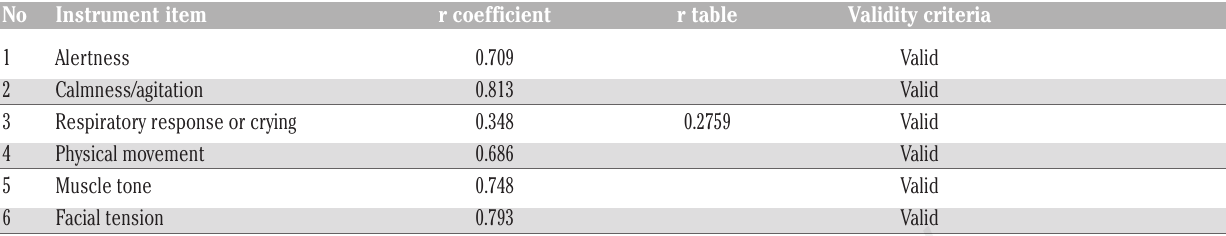
r table Validity